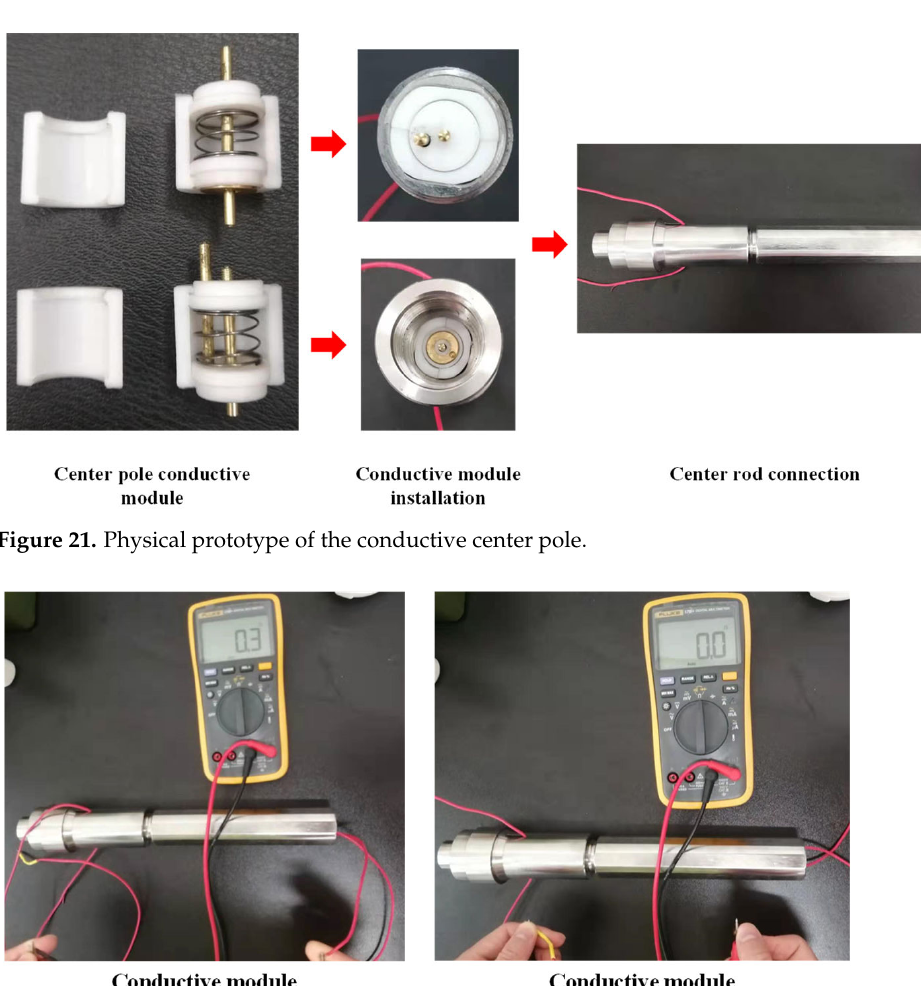
Figure 22. Conductive center pole resistance test.